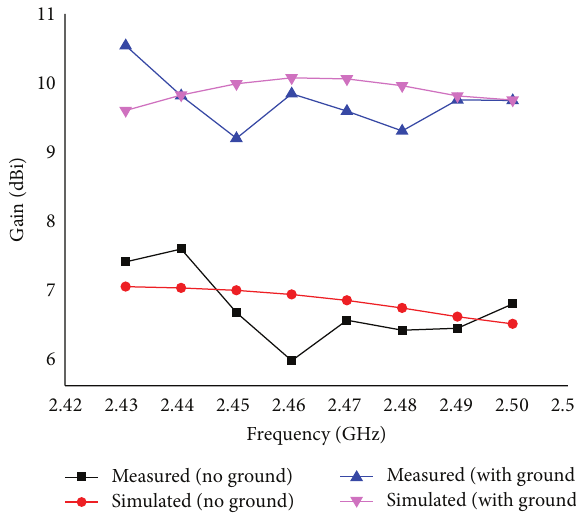
Figure 10: Simulated and measured